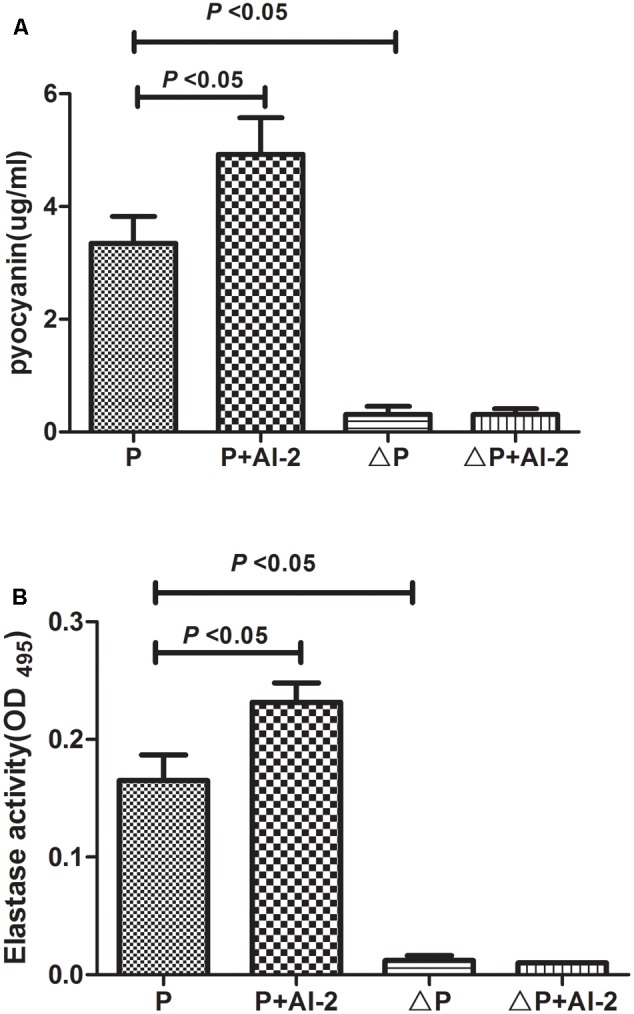
Effects of AI-2 on the production of virulence factors of P. aeruginosa PAO1. P, PAO1 group; P+AI-2, PAO1+AI-2 group; triangleP, P. aeruginosa lasR rhlR mutant group; triangleP+AI-2, P. aeruginosa lasR rhlR mutant+AI-2 group. (A) Relative productions of virulence factors of pyocyanin. (B) Elastase activity.